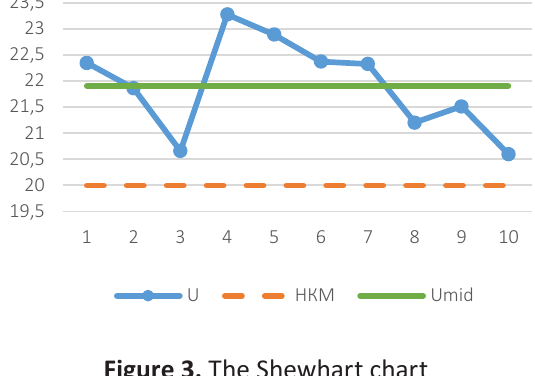
Figure 4. The Shewhart chart for the H5 (current liquidity) evolution